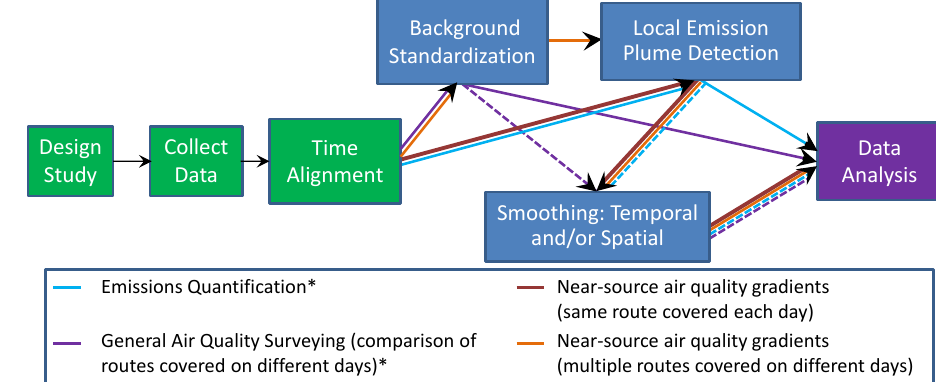
Figure 1. Mobile data-processing